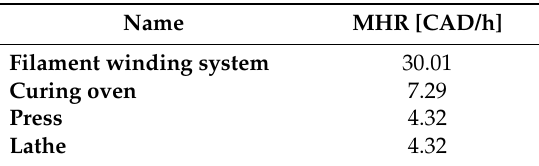
Table 3. MHR for the considered